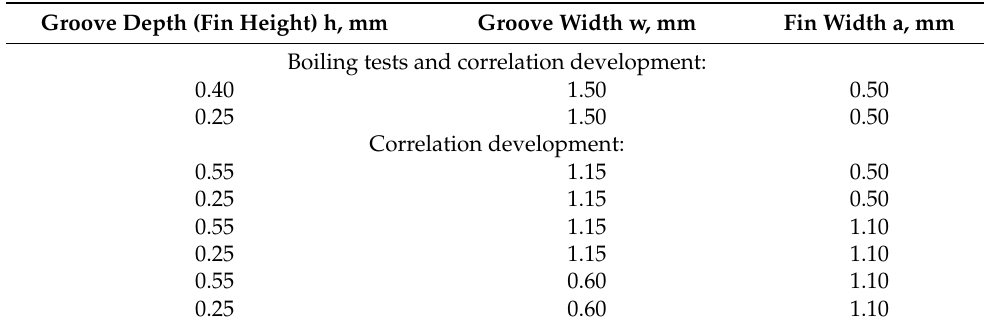
Table 1. Details of the geometrical parameters of the circular